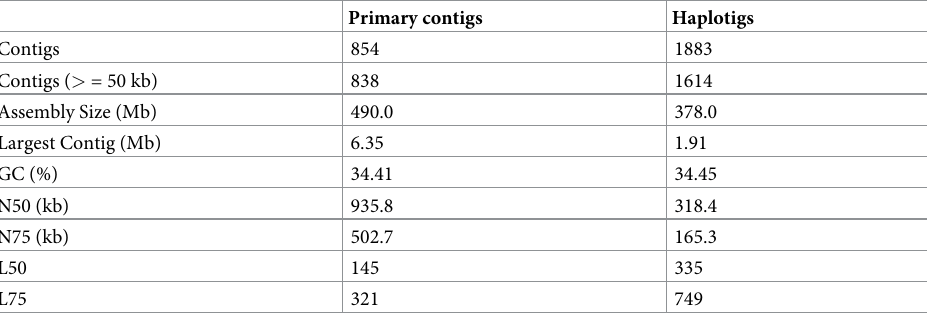
Table 1. Quast-based assembly statistics for the Chardonnay clone I10V1